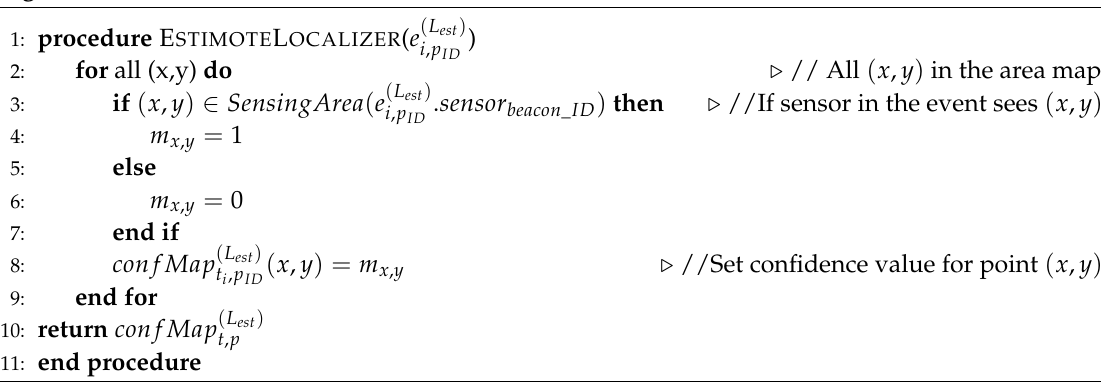
Algorithm 2 Estimote Localizer.